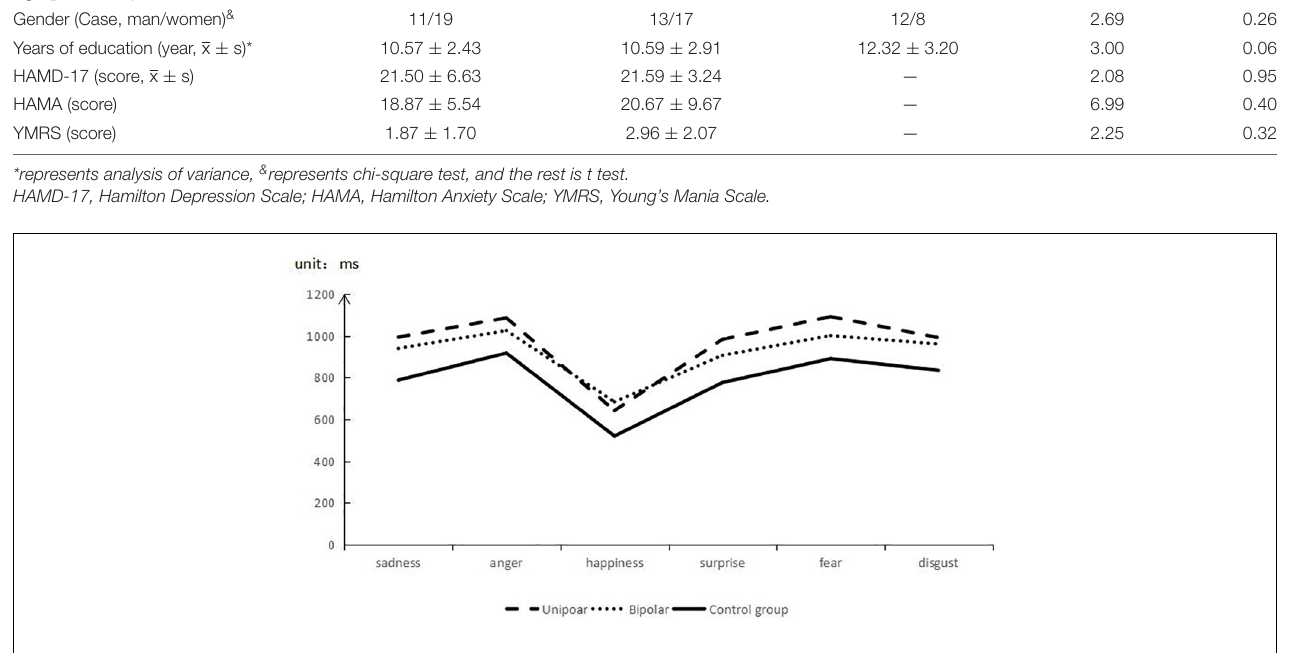
FIGURE 2 | Accuracy of facial expression recognition.